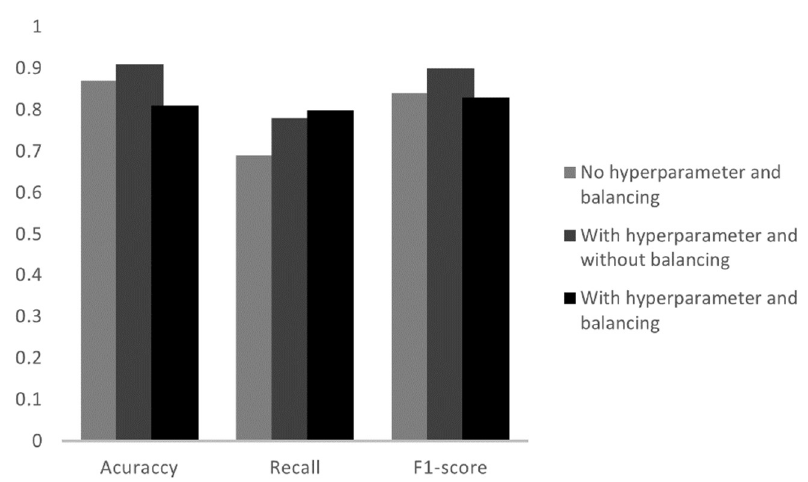
Figure 10. Analysis of the metrics of the three tests in the KNN model. Table 5. KNN parameters with hyperparameters and with unbalanced